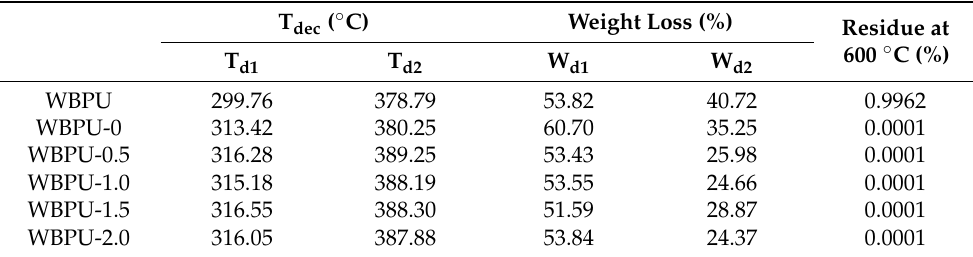
Figure 7. Thermal properties of: ( a ) TG and DTG curve for WBPU; ( b ) TGA and ( c ) DTG curve of WBPU-0, WBPU-0.5, WBPU 1.0, WBPU-1.5 AND WBPU-2.0. Table 3. Thermal properties of nanocomposite